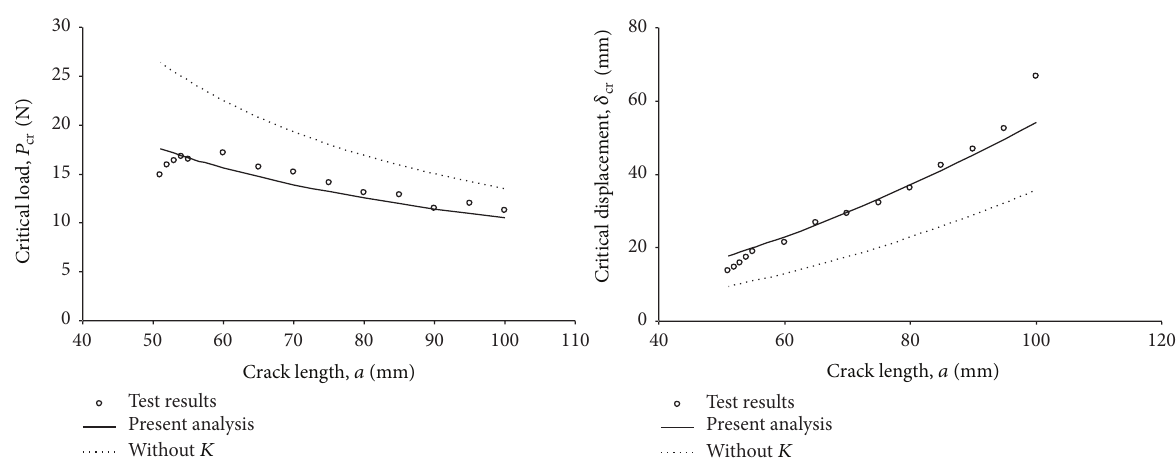
) and the corresponding displacement (𝛿 cr